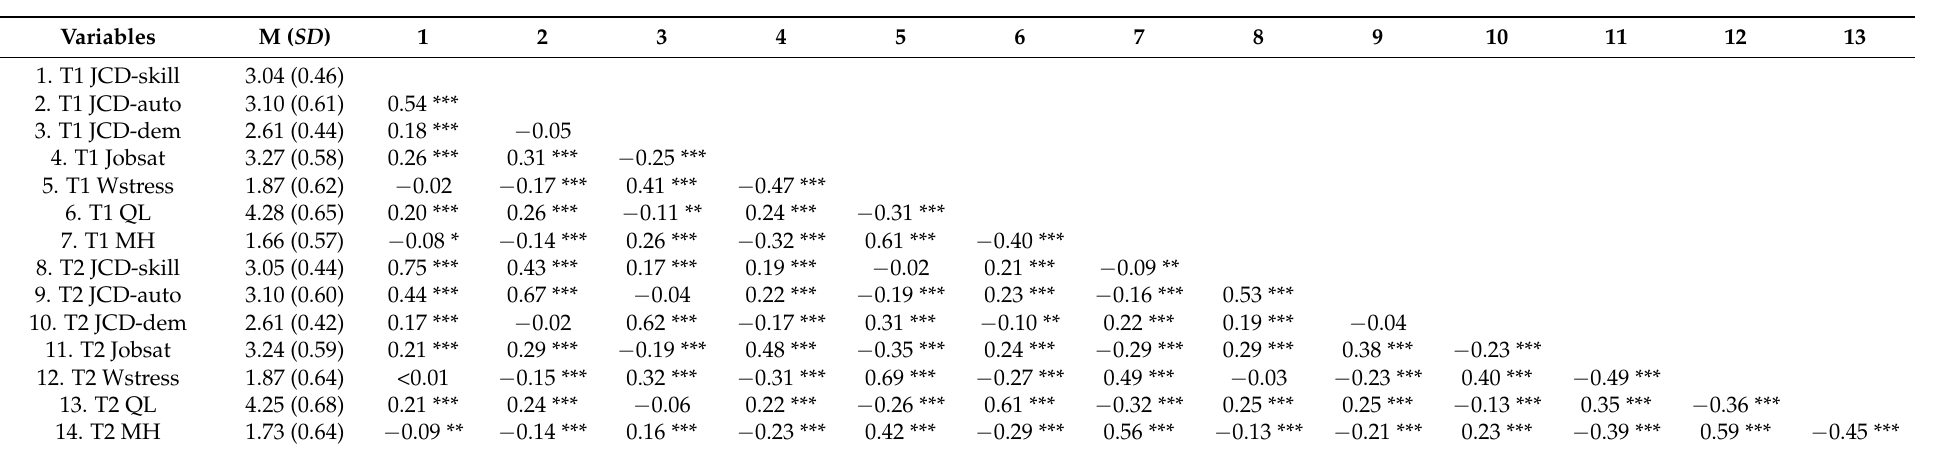
Table 1. Descriptive statistics and correlations between the main study